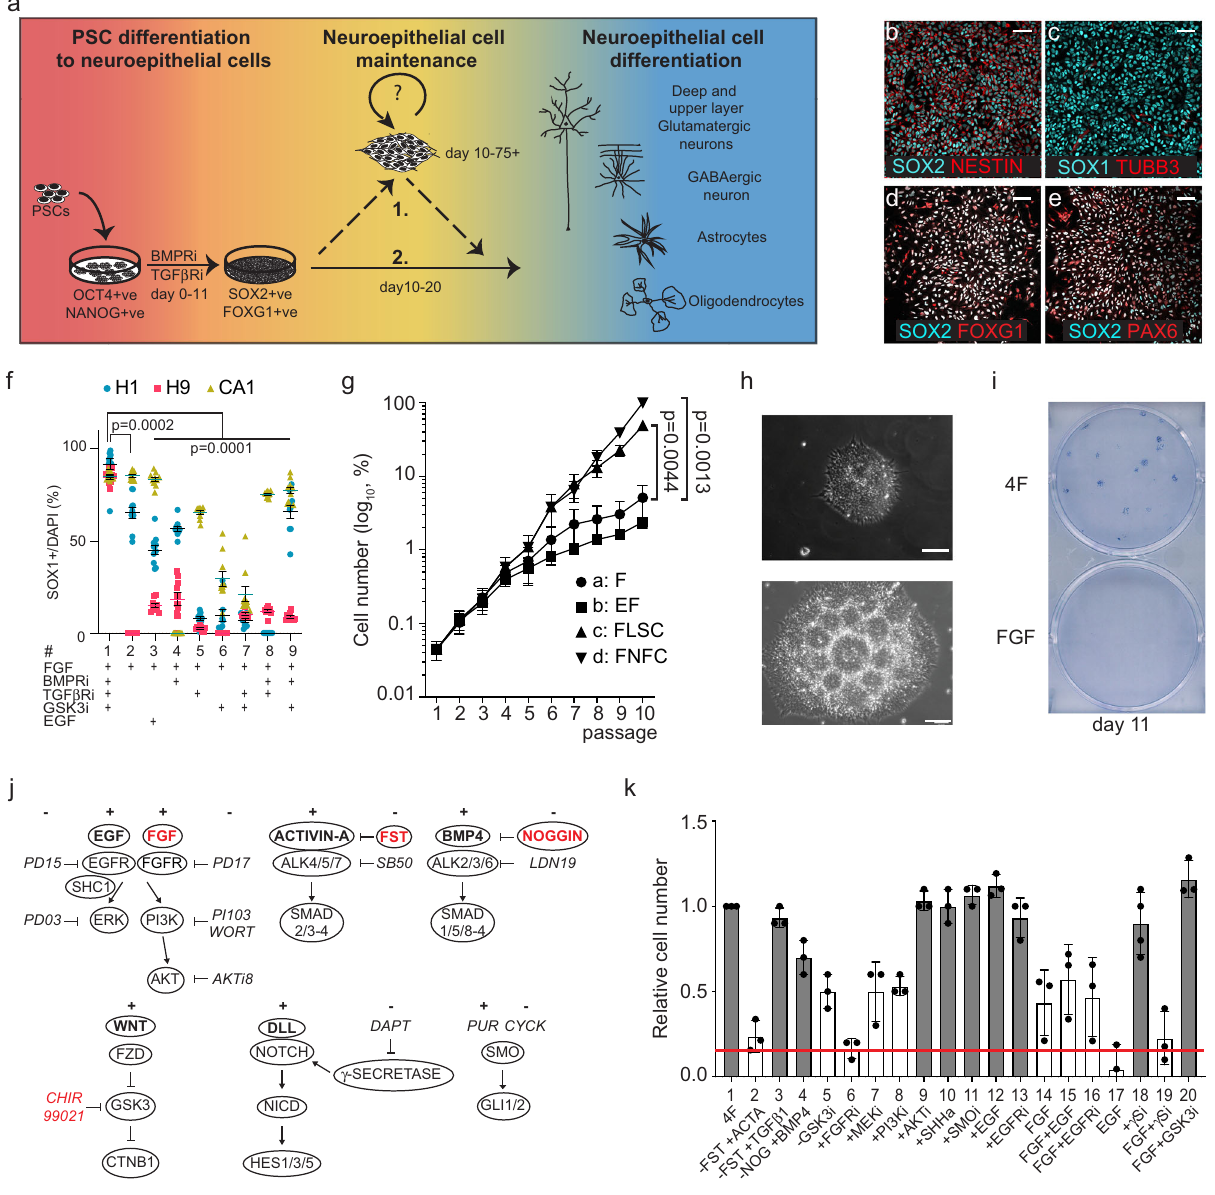
Fig. 1 Induction and maintenance of SOX1 positive dorsal forebrain neuroepithelial cells. a Neural induction scheme of hPSCs in the presence of TGFbR and BMPR inhibitors. After cortical neural induction NES cells express NESTIN in SOX2 positive cells b SOX1 in TUBB3 negative cells c , FOXG1 d , and PAX6 e in SOX2 positive cells. The experiment was repeated with 5 biologically independent cell lines. Scalebar: 25 μ m f SOX1 positive cell ratio in passage 5 cultures of hES (H1, H9, CA1) derived cNESCs treated with various combination of factors ( n = 3 independent cell lines, 10 datapoints per each cell line per group, red bars are mean ± SEM, one-way ANOVA, Tukey ’ s test). g Normalised model of cell number changes of cNESCs (Data are presented as mean ± SEM of H1-, H9-, CA1-derived cells, n = 3 independent cell lines, 2-way ANOVA, Dunnett ’ s test) over 10 passages (30 days). h Phase contrast image of H1 derived cNESCs (p36) in 4F on day 4 (top) and on day 14 of culture (bottom) forming rosette structures. The experiment was repeated with 4 biologically independent cell lines. Scalebar: 50 μ m. i: Colony formation assay of cNESCs cultured in 4F prior to seeding at 200 cells/cm 2 density. j Schematic presentation of developmental signalling pathway components targeted in our assay, protein ligands are in bold and chemical inhibitors are in italic, 4F components are in red. k Quanti fi cation of cell number changes after 96-h treatment of cNESCs with indicated ligands or chemical inhibitors compared to 4F condition ( n = 3 independent experiments, data are presented as mean ± SEM, 1 way ANOVA, Tukey ’ s test, white bars are p < 0.01, grey bars are not signi fi cantly different from control, red line indicates starting cell number). Source data are provided as a Source Data fi le. colonies (Fig. 1g, h). To con fi rm that the expansion of cNESCs in NOGGIN (BMPi), FOLLISTATIN (ACTIVINi), and CHIR99021 4F was not associated with any speci fi c chromosomal abnorm- (GSK3i), abbreviated as FNFC. Con fi rming previous fi ndings, alities we examined the karyotype of cNESCs maintained for over after six passages, cNESCs in FGF alone and FGF and EGF 100 days in vitro (more than 50 population doublings) in two had a lower proliferation rate than in previous passages. In independent cell lines and found no chromosomal aberrations contrast, cNESCs in both FLSC and FNFC showed sustained (Supplementary Fig. 1e). proliferation and supported the formation of neuroepithelial NATURE COMMUNICATIONS| (2022) 13:2844